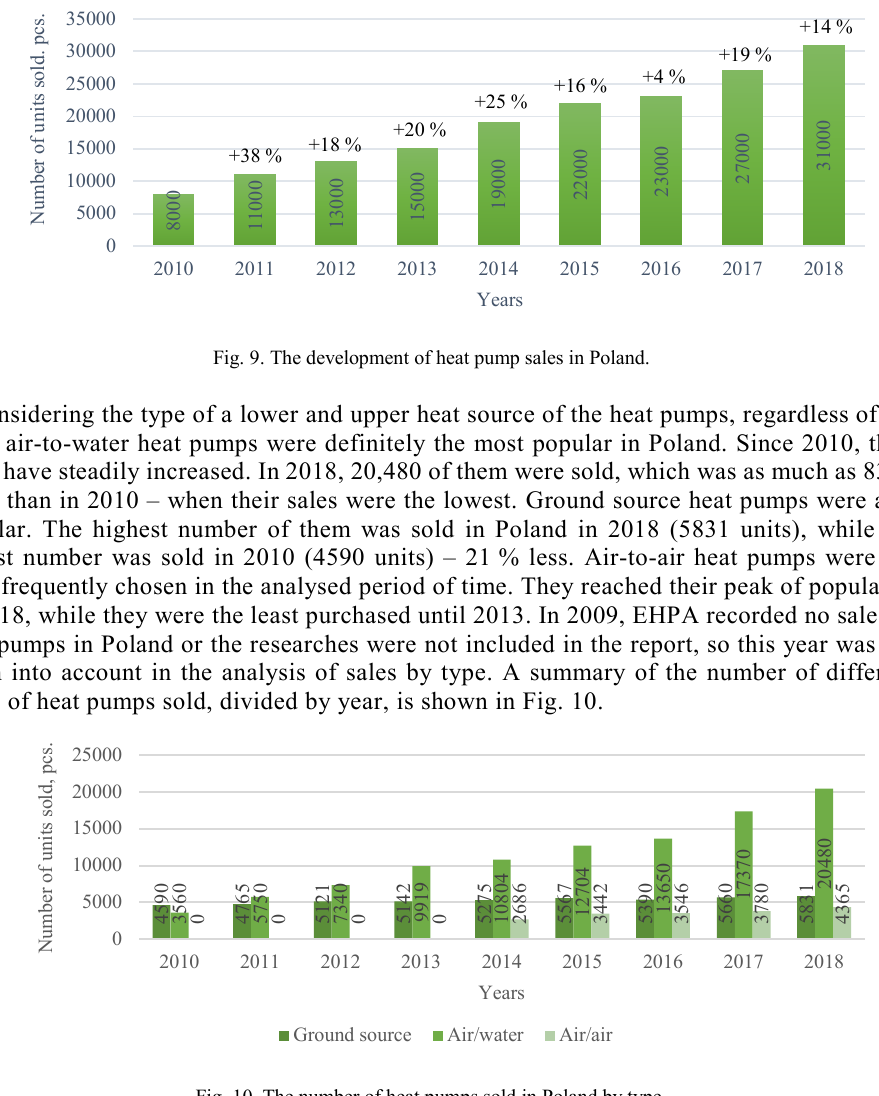
Fig. 10. The number of heat pumps sold in Poland by